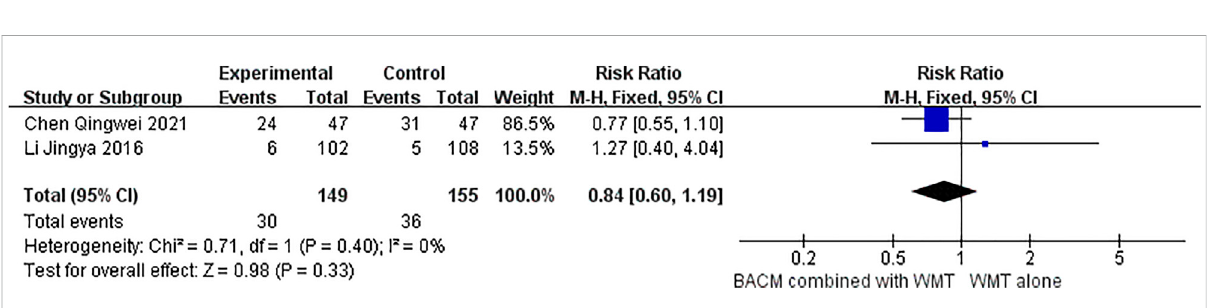
FIGURE 9 The forest plot of the incidence of side effects due to BACM for